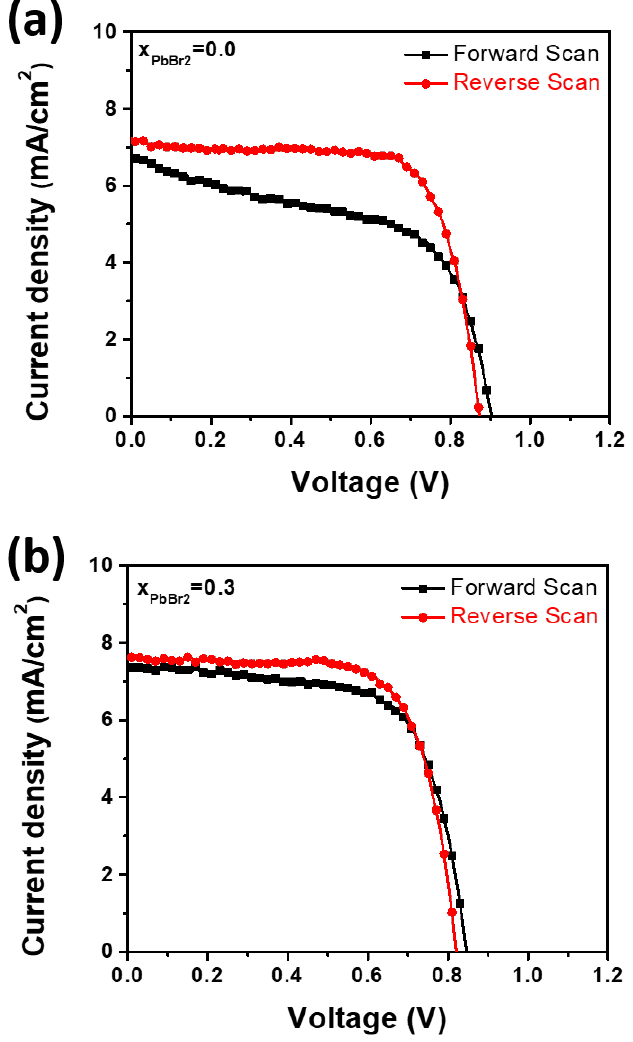
Figure 10. J-V curves measured by forward (from J sc to V oc ) and reverse (from V oc to J sc ) scans for the solar cells fabricated at x = ( a ) 0.0 and ( b ) 0.3.